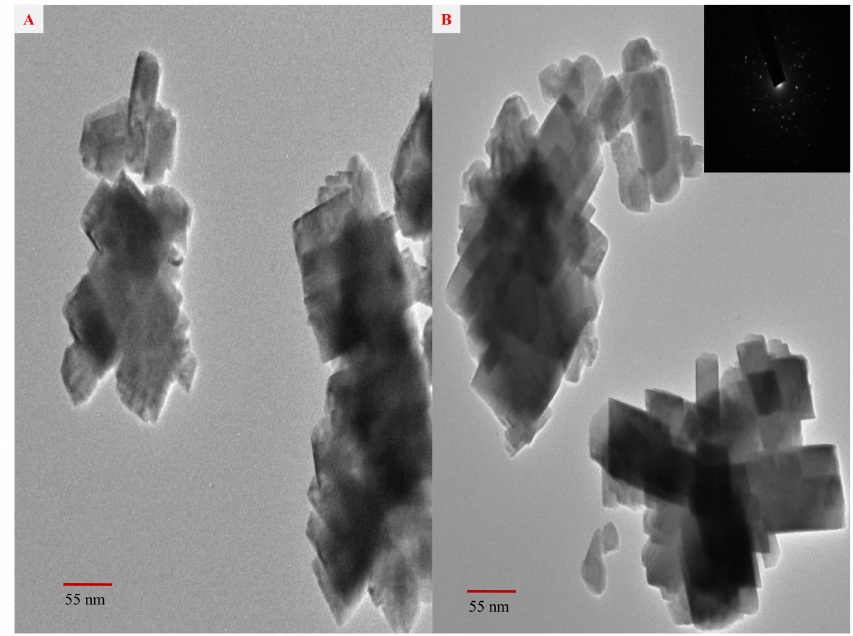
Figure 3. ( A , B ) TEM images (SAED as inset) of the biosynthesized AgNPs showing rectangular